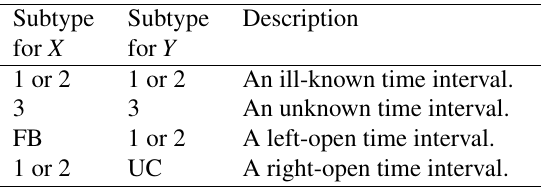
Table 9. All the possible combination of values for the time interval [ X , Y ] . The subtypes refer to Table